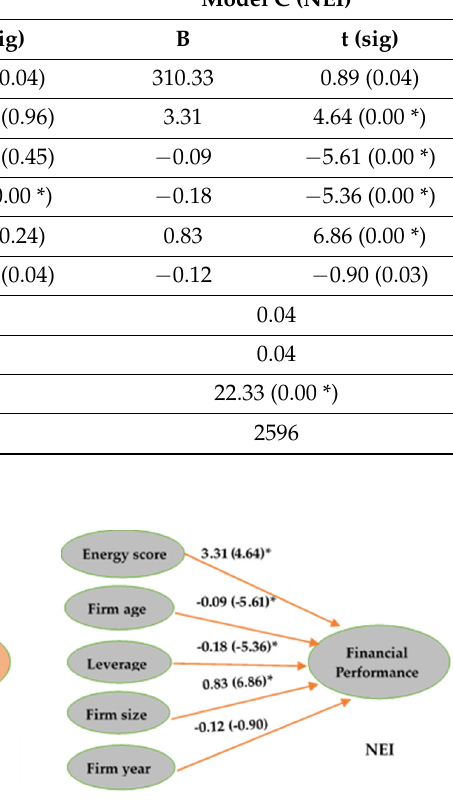
Figure 2. Multiple regression analysis results, * p < 0.05.